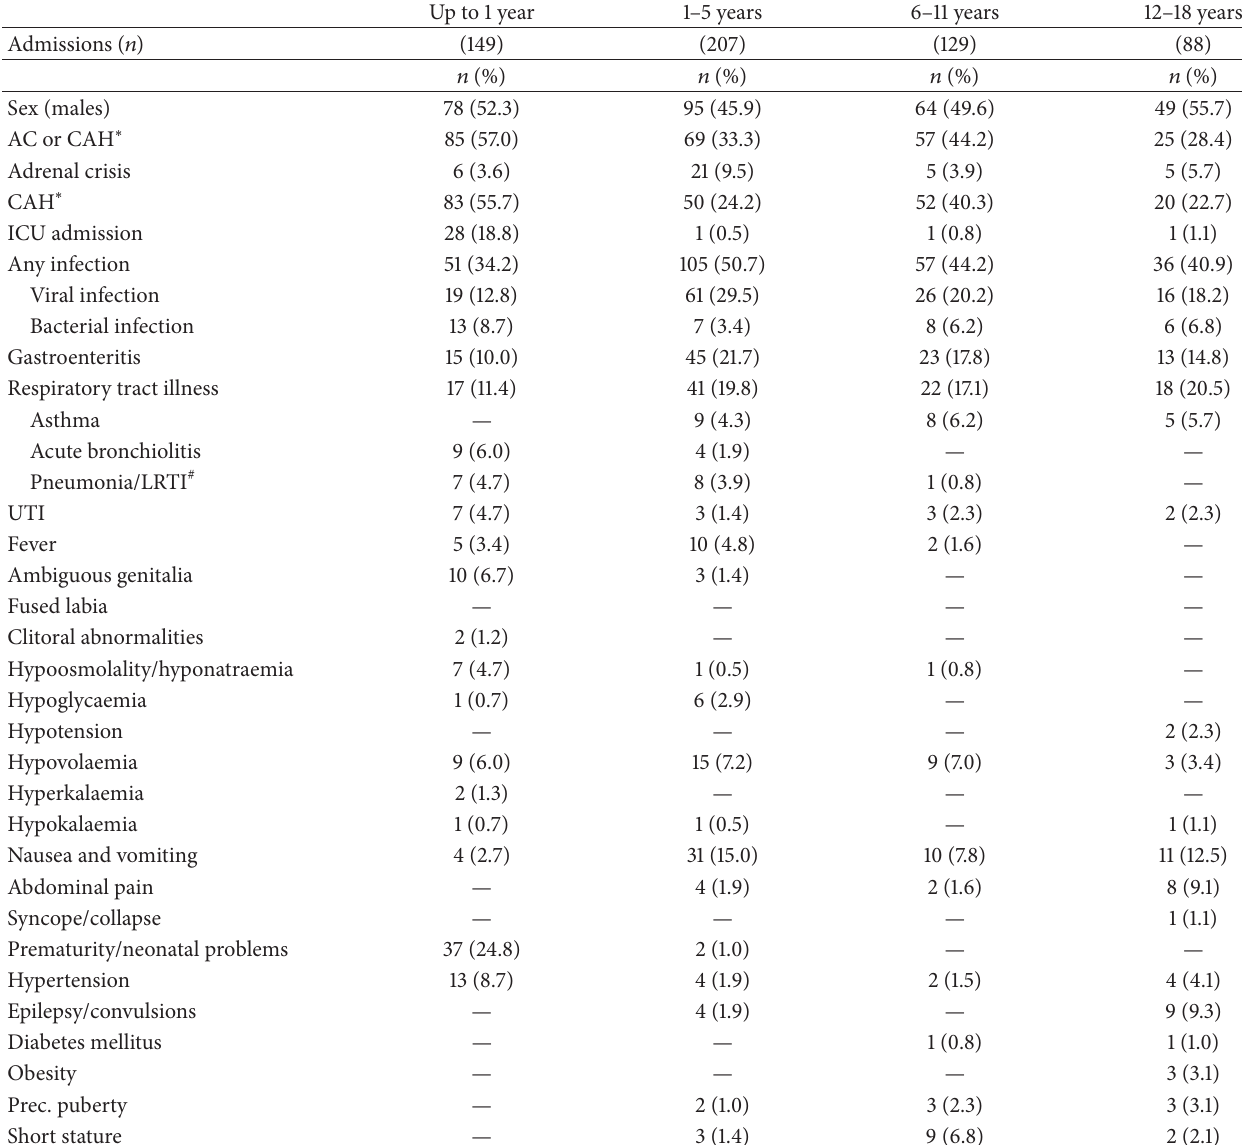
Table 2: Comorbid conditions in patients with CAH by age, NSW,